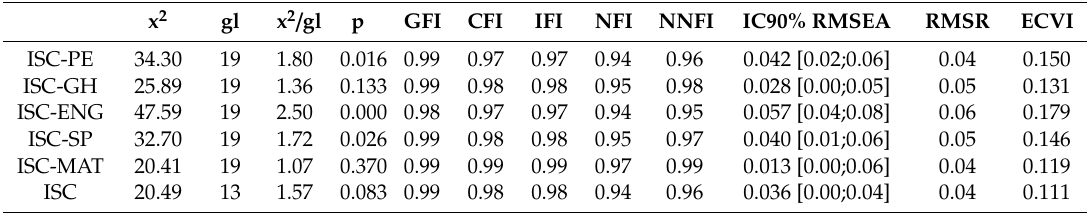
Table 3. Scale of reliability and composite Table 2. Models fit index.